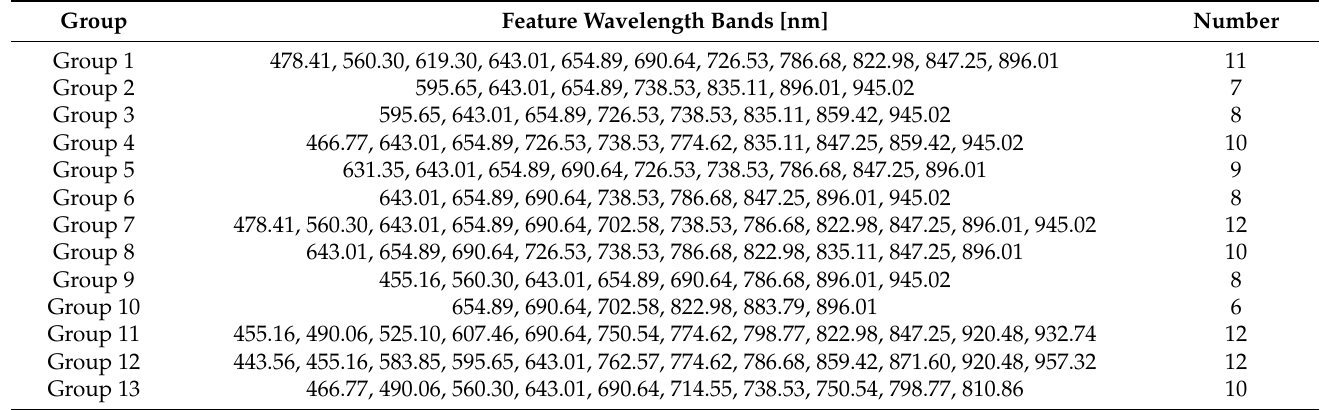
Table 4. The results of feature wavelength bands selected using SD data under different adulteration